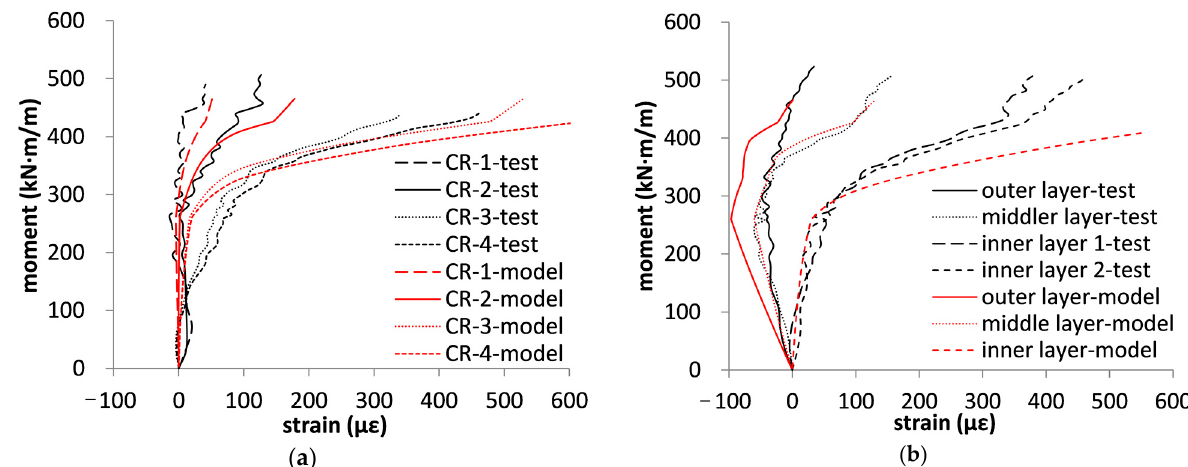
Figure 18. Evolution of the connecting reinforcement strains with increasing bending moments: ( a ) along the inner layer; ( b ) on different layers at the measurement section.